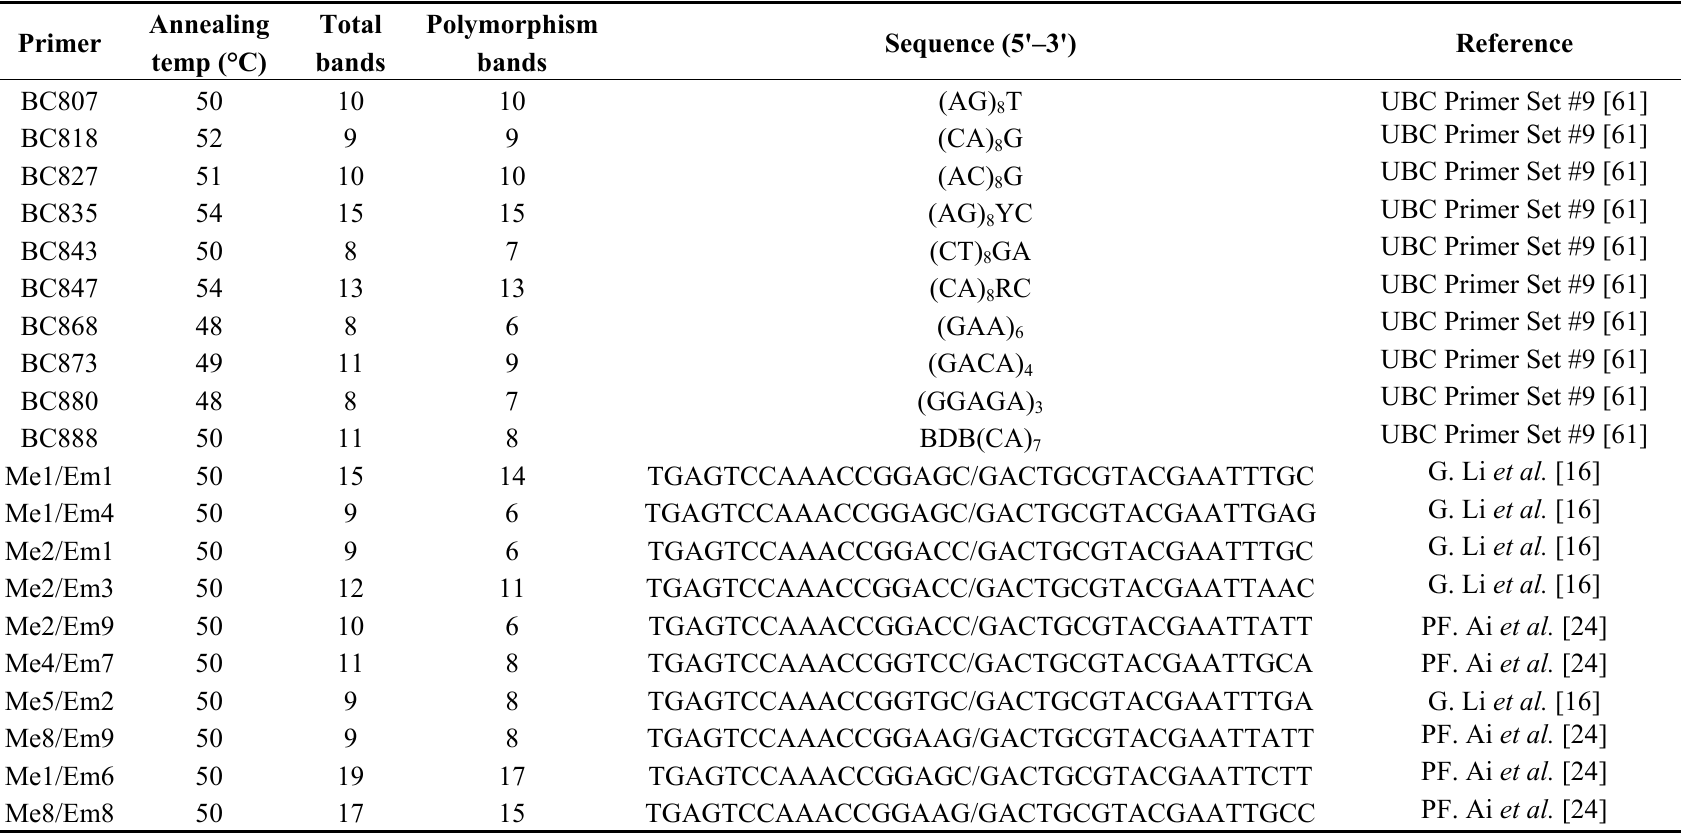
Table S1. ISSR and SRAP primers that produced repeatable polymorphic amplification patterns for the genotypes